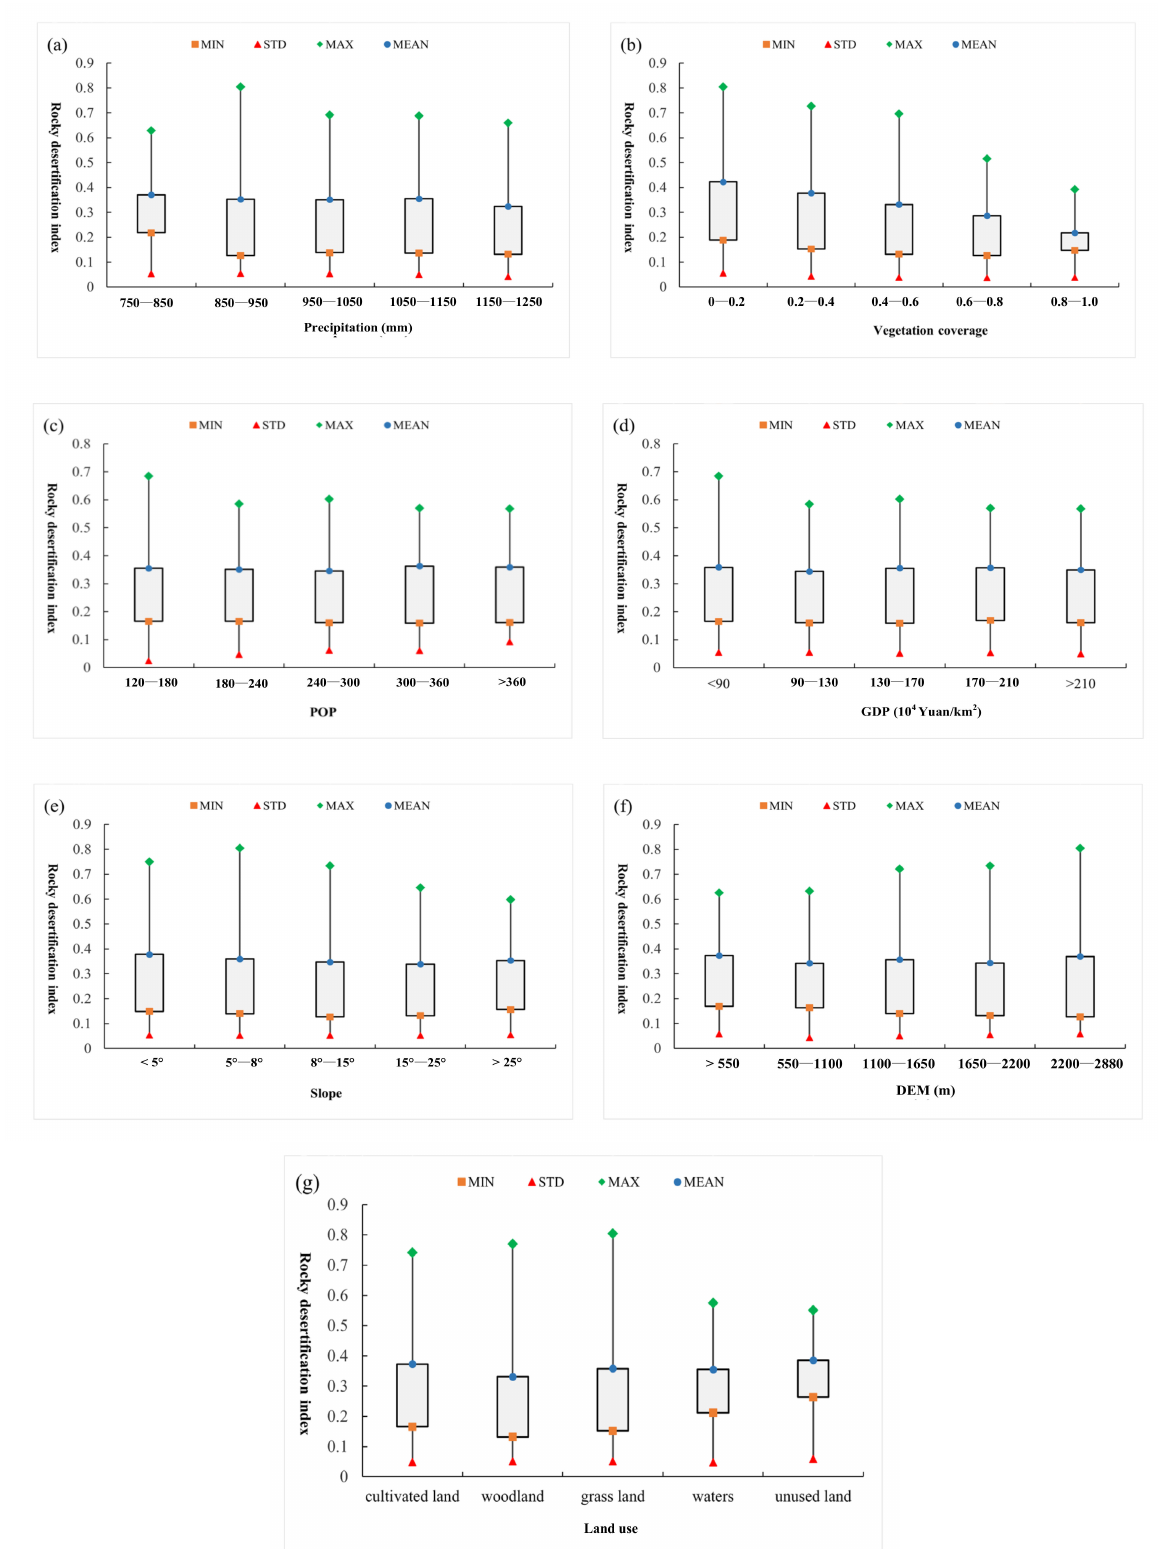
Figure 10. Correlations between different single driving factors and rocky desertification. MIN refers to the minimum value, STD refers to the standard deviation, MAX refers to the maximum value, and MEAN refers to the mean value. ( a ) Precipitation; ( b ) Vegetation coverage; ( c ) Pop; ( d ) GDP; ( e ) Slope; ( f ) DEM; ( g ) Land